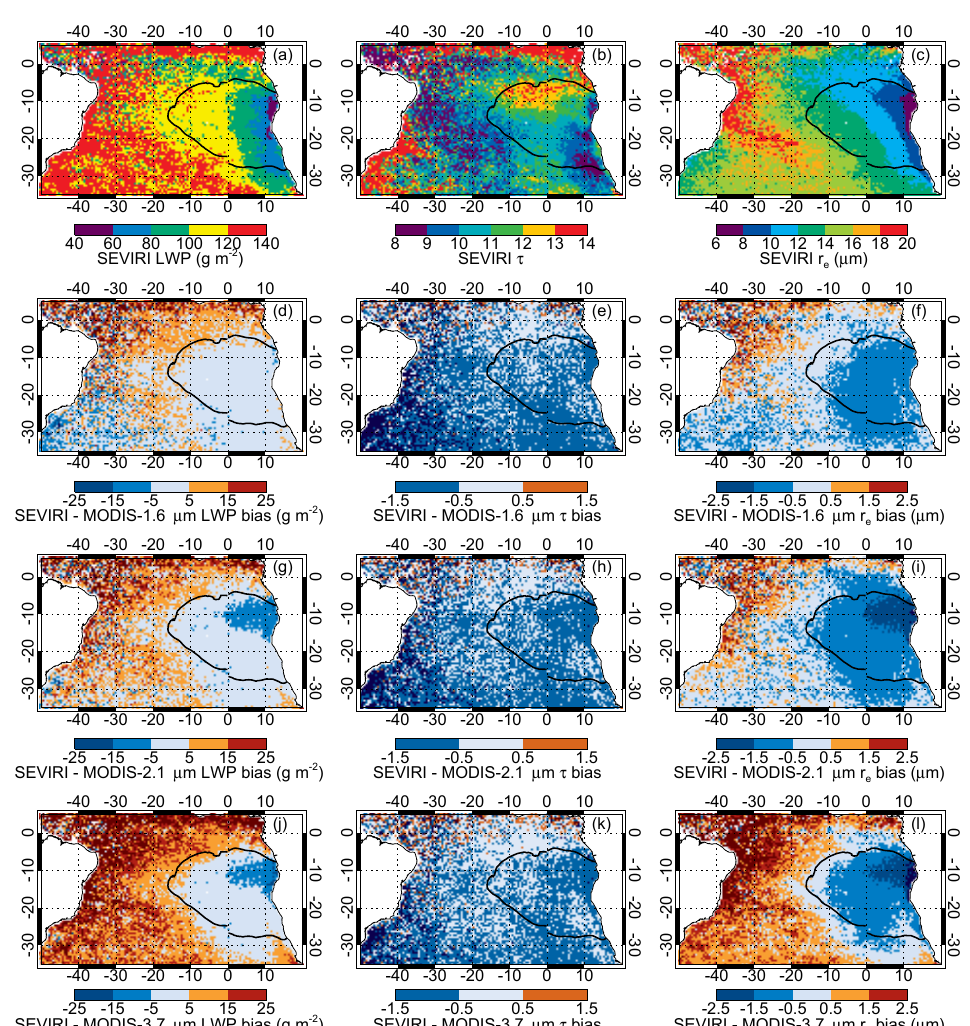
Figure 6. The 2-year-mean map of (a) SEVIRI LWP, (b) SEVIRI τ , (c) SEVIRI r e , (d, g, j) SEVIRI minus MODIS liquid water path biases, (e, h, k) SEVIRI minus MODIS cloud optical thickness biases, and (f, i, l) SEVIRI minus MODIS droplet effective radius biases for the overcast case (LCF ≥ 95% and τ > 3) in ice- and smoke-free conditions.